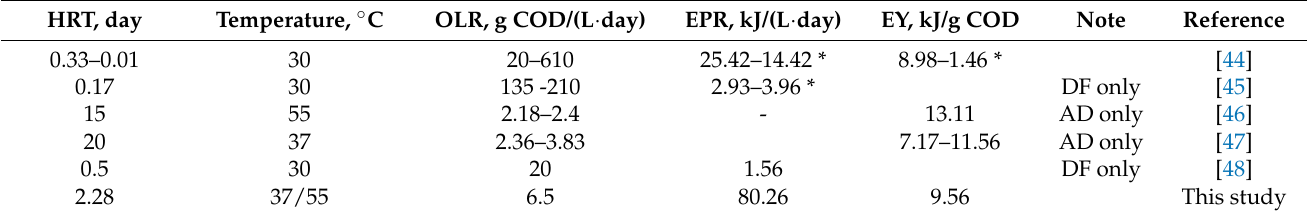
Table 7. Energy recovery from different one- and two-stage